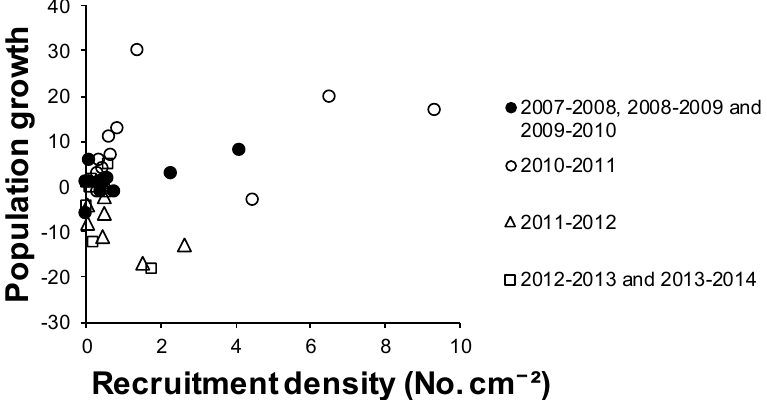
Figure 4. Relationship between annual recruitment density and population growth of Balanus glandula at each plot along the coast of eastern Hokkaido during 2004 − 2014. Population growth was estimated as the change in coverage between year t − 1 and year t each site. Table 2. Spearman’s rank correlation coefficients between annual recruitment density in year t − 1 at each site and the change in coverage between years t − 1 and t at each site during 2004–2014 Year n